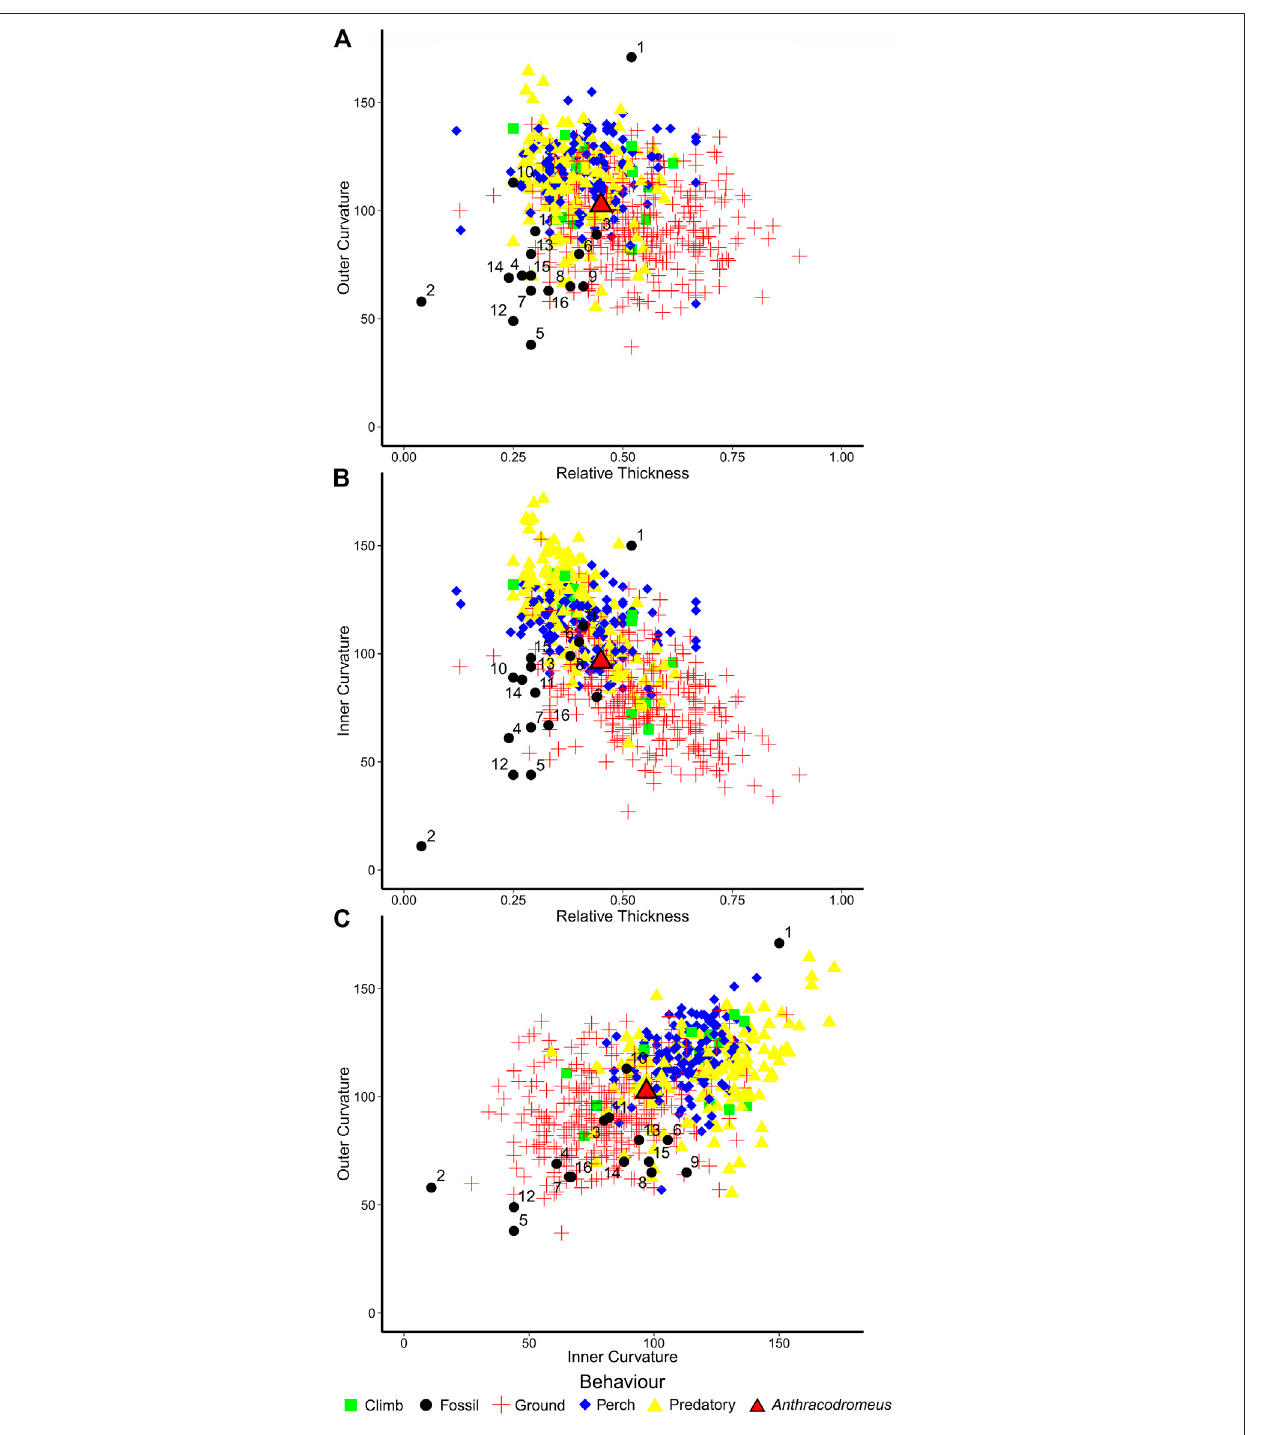
FIGURE 4 | Scatterplots of claw curvature and thickness from Birn-Jeffery et al. (2012) showing placement of Anthracodromeus and other coeval amniotes. (A) outer claw curvature vs. relative claw thickness, (B) inner claw curvature vs. relative claw thickness, and (C) outer claw curvature vs. inner claw curvature. Taxa: 1 , Ascendonanus nesterli ; 2 , Batropetes fritschi ; 3 , Cabarzia trostheidei ; 4 , Captorhinus aguti ; 5 , Cotylorhynchus romeri ; 6 , Dimetrodon limbatus ; 7 , Edaphosaurus boanerges ; 8 , Eocasea martini ; 9 , Erpetonyx arsenaultorum ; 10 , Haptodus garnettensis ; 11 , Martensius bromackerensis ; 12 , Mesenosaurus romeri ; 13 , Palaeohatteria longicaudata ; 14 , Spinoaequalis schultzei ; 15 , Suminia getmanovi ; 16 , Varanops sp.